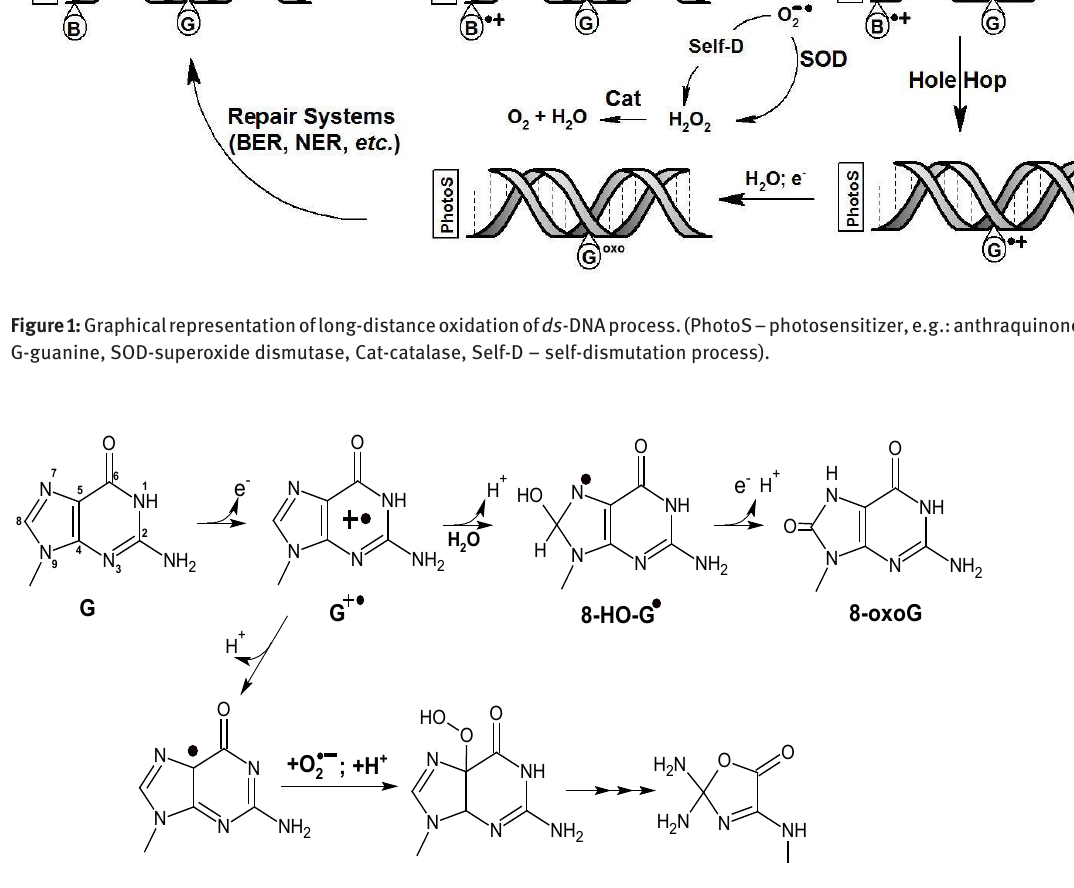
Figure 2: The formation of 8-oxoG and oxazolone in the one-electron oxidation process